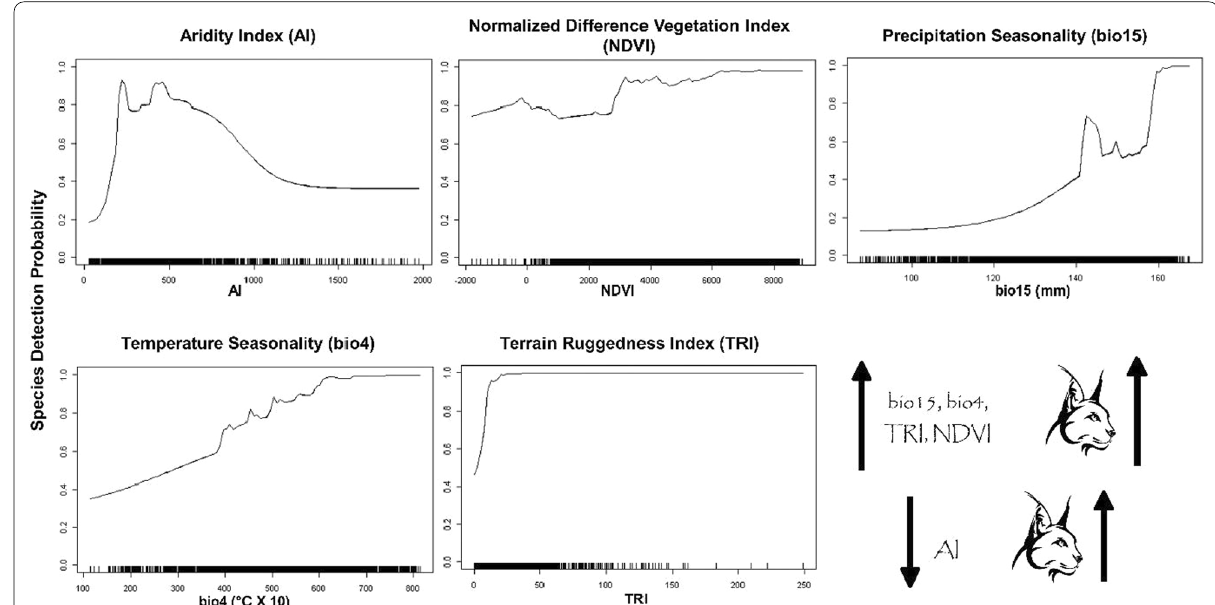
Fig. 5 Plots depicting the responses of species habitat suitability towards the predictor variables (Aridity Index, Normalized Difference Vegetation Index, Precipitation Seasonality, Temperature Seasonality and Terrain Ruggedness, from top left to mid down, respectively) used for forming the ensemble model for habitat suitability of Asiatic caracals in the study